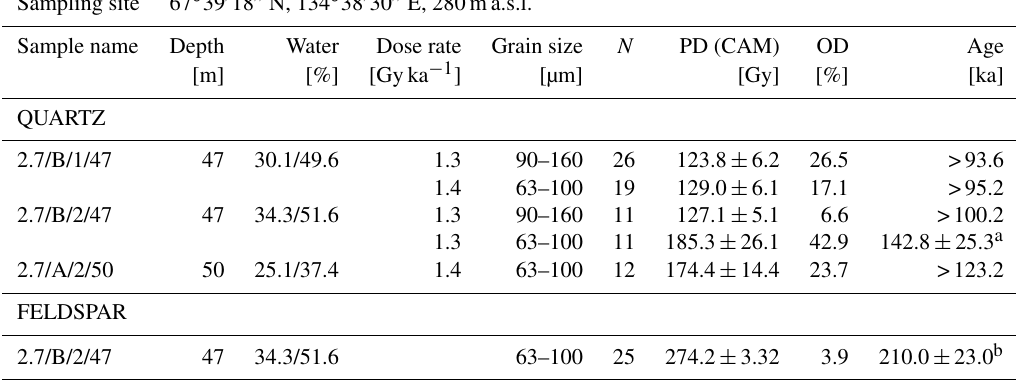
Table 3. OSL and IRSL measurement data and respective dating results for the luminescence samples from Unit IV of the Batagay permafrost exposure Dose rate is the effective dose rate calculated based on results from gamma spectrometry and cosmic dose rate and corrected for mineral density, sediment density, grain sizes, and water content. Water is the in situ water content and saturation water content. N is the number of aliquots. PD is the palaeo-dose based on central age model, CAM, according to Galbraith et al. (1999). OD is the overdispersion. Age is the calculated ages according to CAM using the in situ water content. The > sign indicates that minimum age signals were close to saturation and hence tend to underestimate luminescence